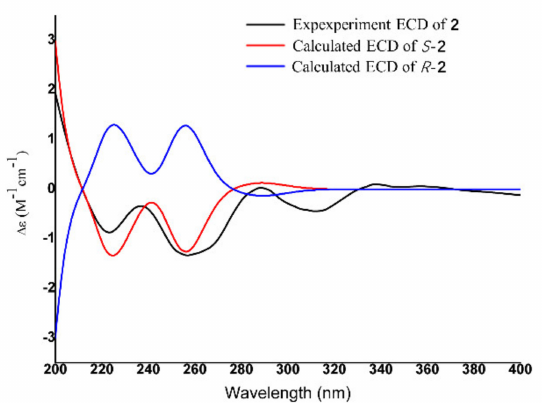
Figure 8. Experimental ECD spectra (200 − 400 nm) of 2S in methanol and the calculated ECD spectra of the model molecules of 2S at the PBE0/def2-TZVP level.